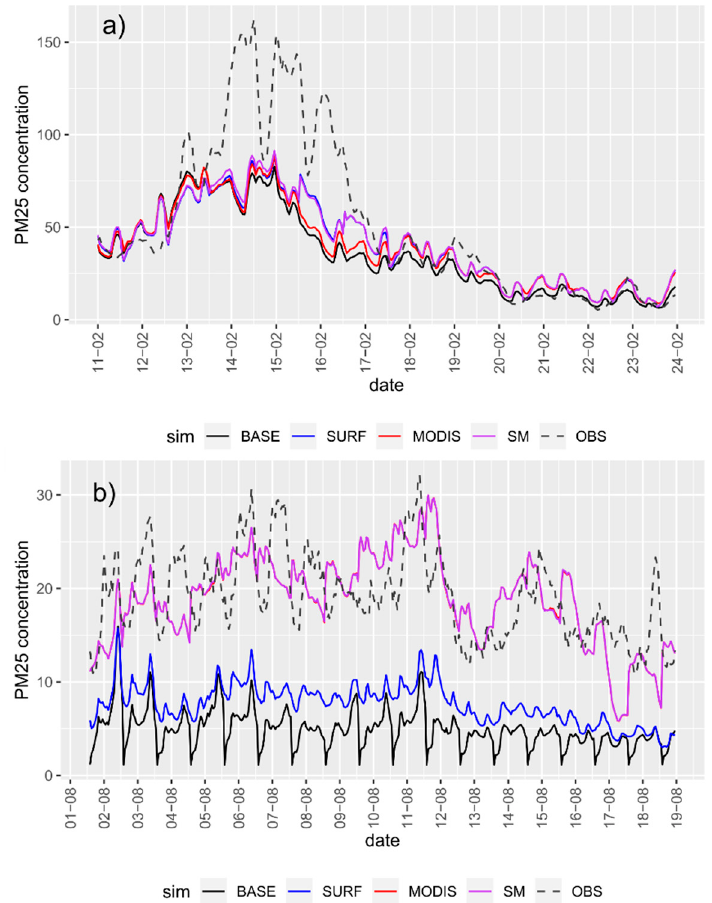
Figure 3. Time series of PM2.5 concentrations (mean from all stations) for ( a ) winter 2017 and ( b ) summer 2015 episodes over Poland. Unit: µg m –3 . Please note that there are different scales for the y-axis for plot (a) and (b).